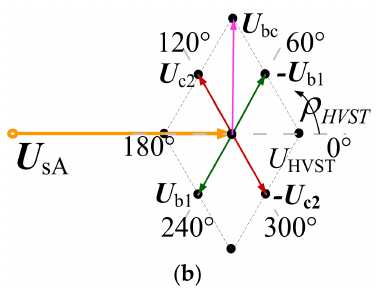
Figure 3. HVST partial enlarged configuration and output voltage phasor. ( a ) Enlarged HVST configuration; ( b ) Output voltage phasor U HVSTA (m =